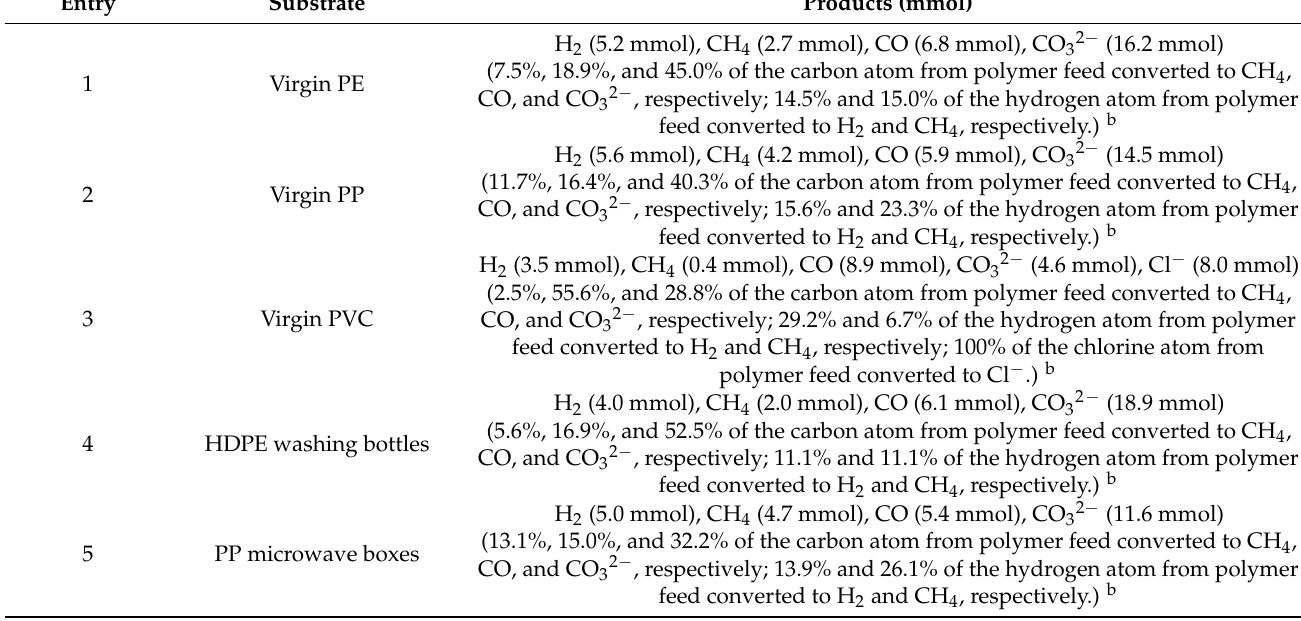
Table 1. Characteristics of the products recovered from the mechanochemical degradation of PE (0.50 g, 18 mmol), PP (0.50 g, 12 mmol), or PVC (0.50 g, 8 mmol) with using KMnO 4 (1.2 molar equivalents: 21.6 mmol for PE; 14.4 mmol for PP; and 9.6 mmol for PVC) a